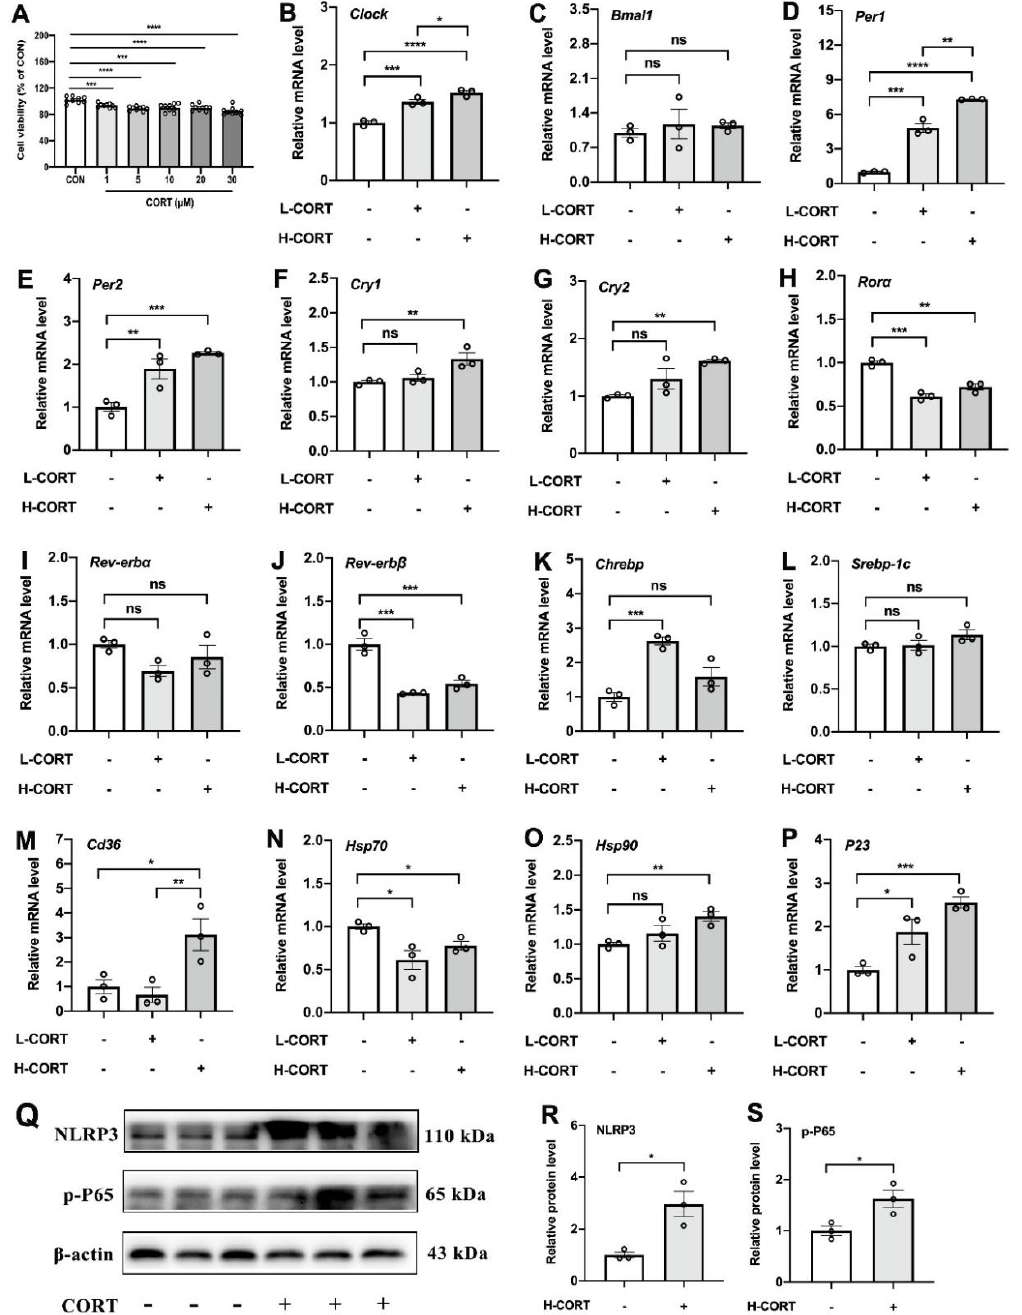
Figure 6. The role of CORT in interference with the adipose circadian rhythms. ( A ) Cell viability (% of CON). ( B – P ) Relative mRNA expression levels of Clock, Bmal1, Per1, Per2, Cry1, Cry2, Ror α , Rev-erb α , Rev-erb β , Chrebp, Srebp-1c, Cd36, Hsp70, Hsp90, and P23 in 3T3-L1 cells treated by CORT ( n = 3). ( Q – S ) Relative protein levels of NLRP3 and p-P65 ( n = 3). The circles represent the number of samples. The results are presented as the means ± SEM. * p < 0.05, ** p < 0.01, *** p < 0.001, **** p < 0.0001.